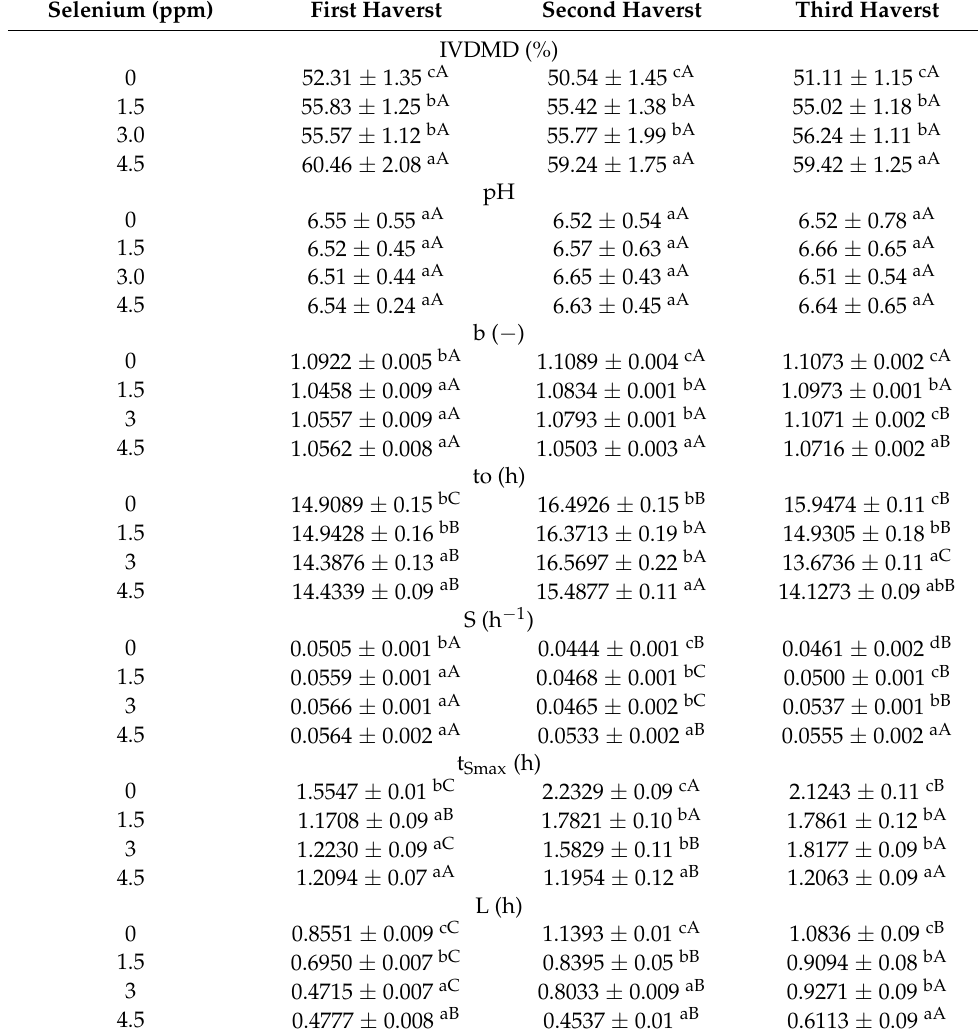
Table 2. Digestibility parameters after 92 h of